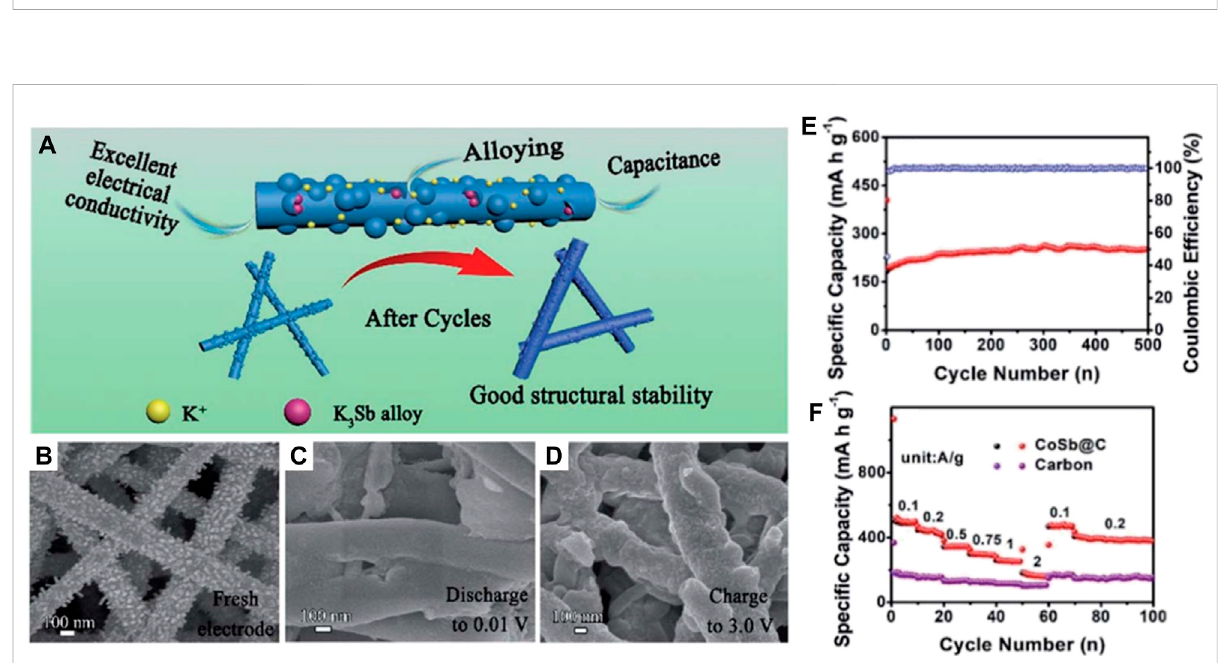
FIGURE 5 (A) Schematic diagram of the electrochemical enhancement mechanism of CoSb@C nano fi bers. (B – D) SEM images of CoSb@C nano fi bers during the initial cycle process. (E) Rate performance and (F) long-term K + storage performance of CoSb@C nano fi bers ’ electrode at 1 A g − 1 . Reproduced with permission (Han et al., 2019). Copyright 2019